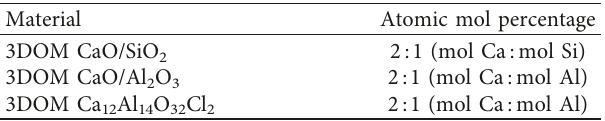
Table 1: Atomic mol percentage used for Ca-doped 3DOM ma- terial